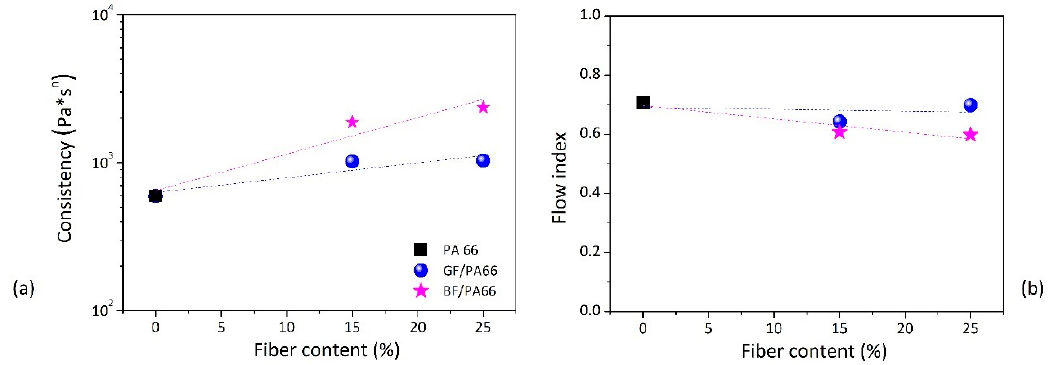
Figure 6. Consistency ( a ) and index flow ( b ) against filler loading. Lines in figures are to guide the eyes.